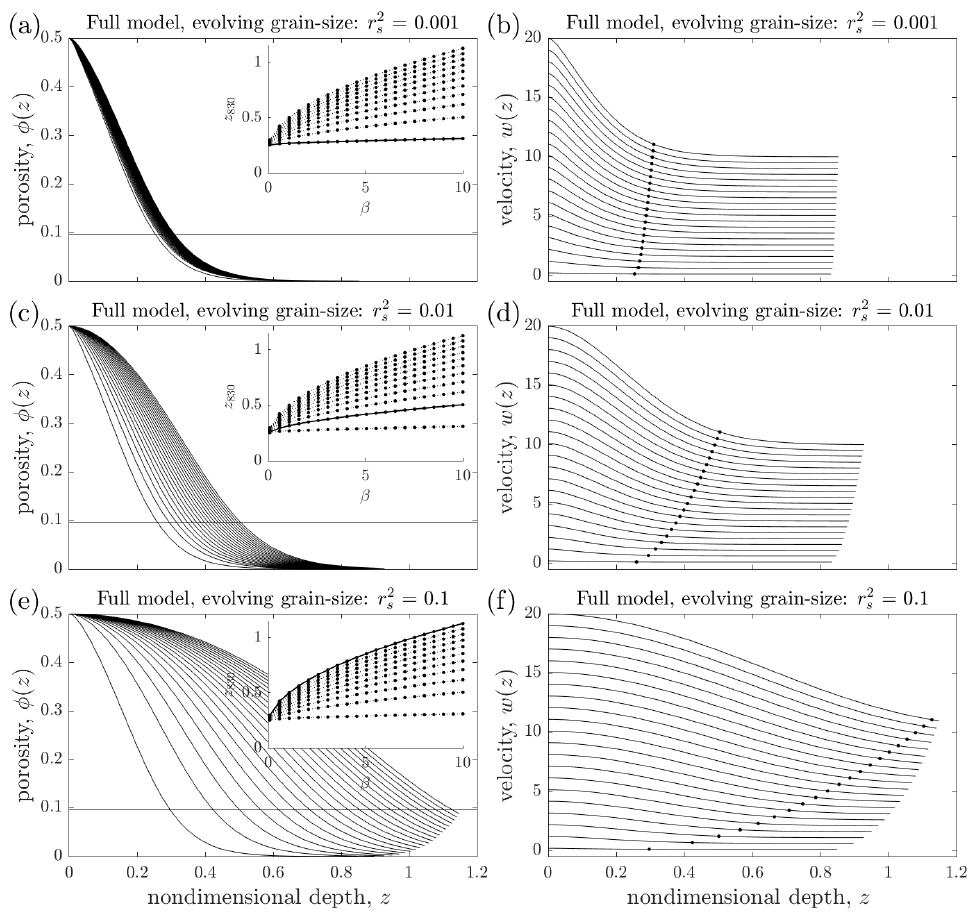
Figure 4. Accumulation dependence of the full model, with a grain size that evolves. The layout is similar to Fig. 3, except that only results from the full model are shown, and the rows display results from three sets of selected simulations from among 11 sets of simulations, each using a different value of the surface grain size, r 2 s . Across each set of simulations the accumulation varies linearly between 0.1 and 10. The insets in (a) , (c) , and (e) show the dependence of firn thickness z 830 on accumulation rate β for all 11 sets of simulations (dotted curves), with each solid curve corresponding to the results shown in each row. The horizontal lines in the left panels show the porosity corresponding to z 830 (0.096). The dots in the right panels show the depth at which the firn reaches 830kgm − 3